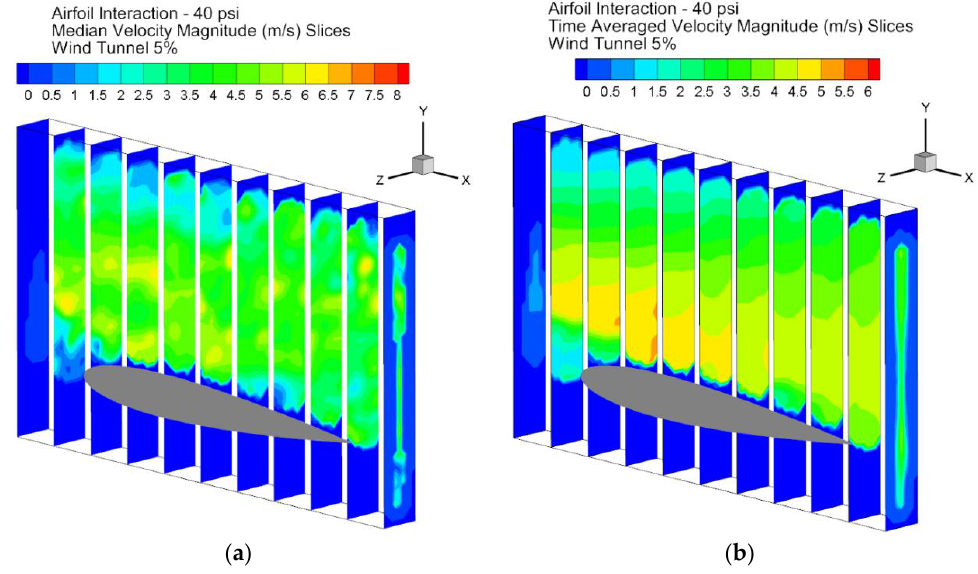
Figure 25. Airfoil interaction: ( a ) instantaneous median frame velocity maps and ( b ) average velocity maps; vortex generator, 40 psi.